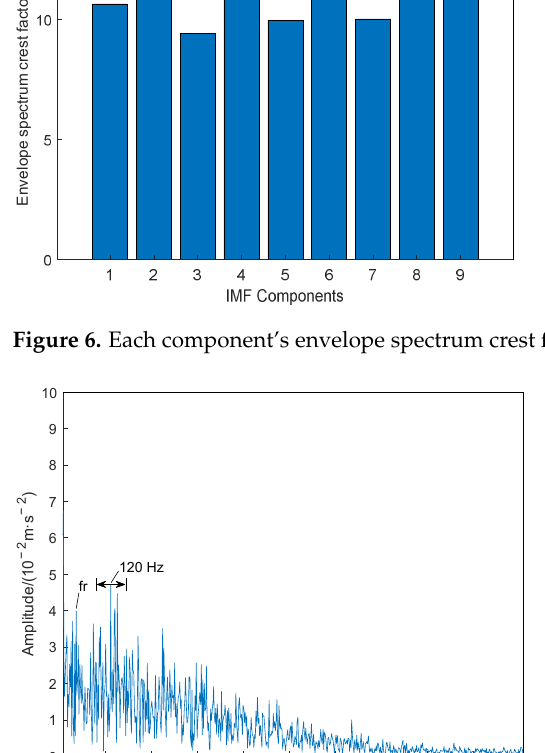
Figure 6. Each component’s envelope spectrum crest factor value.